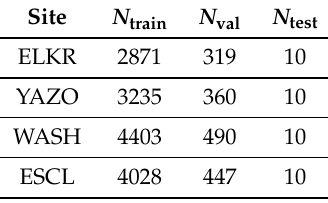
Table 5. Number of samples for training ( N train ), validation ( N val ), and test ( N test ) sets for each